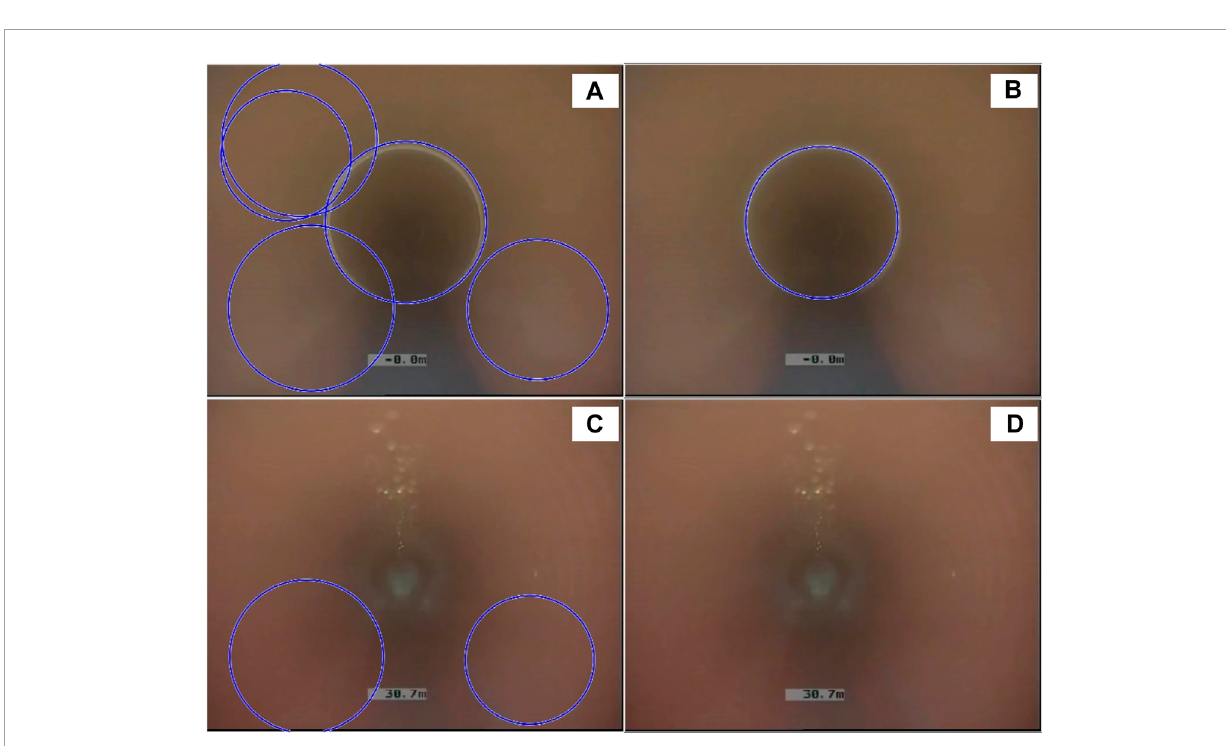
FIGURE 7 Pipe joint detection using our proposed method based on a bag-of-keypoints feature recognition method versus the Hough transform. (A) Hough transform: the single joint is correctly detected but there are also multiple false positive circle detections (with different radii). (B) Bag-of-keypoints method: the single joint is correctly detected with no false positives. (C) Hough transform: there is no joint present in the frame but the Hough transform still detects circles. (D) Bag-of-keypoints method: no joint is present in the frame, which the method correctly